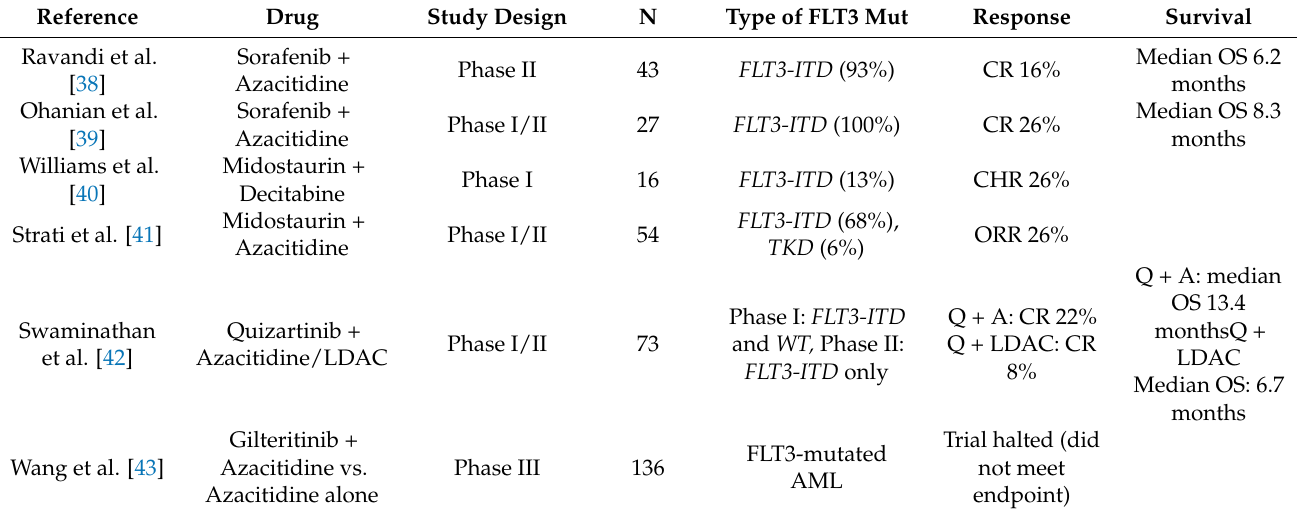
Table 4. FLT3 TKIs in combination with demethylating